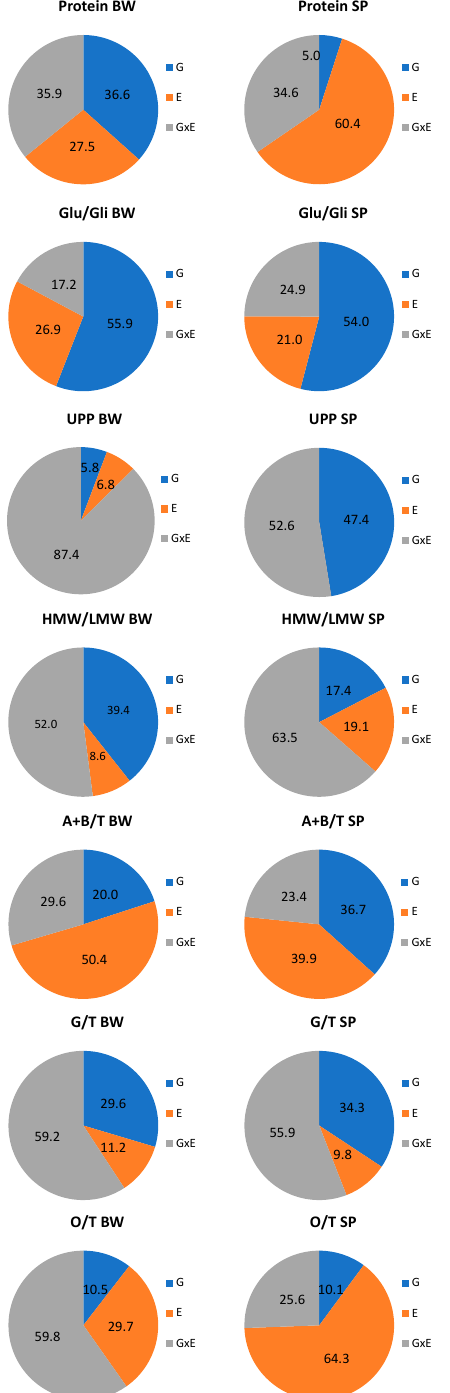
Figure 4. Pie diagrams of the relative contribution of genotype (G), environment (E—3 growing sites), genotype × environment interaction (G × E) to the total sum of squares for the protein content and composition for spelt (SP) and bread wheat (BW), PC—total protein content, Glu/Gli—the quantitative ratio of glutenins to gliadins, UPP%—unextractable polymeric proteins, HMW/LMW—the quantitative ratio of high molecular weight and low molecular weight glutenin subunits, A+B/T—the portion of alfa and beta gliadins in total gliadins, G/T—the portion of gamma gliadins in total gliadins, O/T—the portion of omega gliadins in total gliadins.